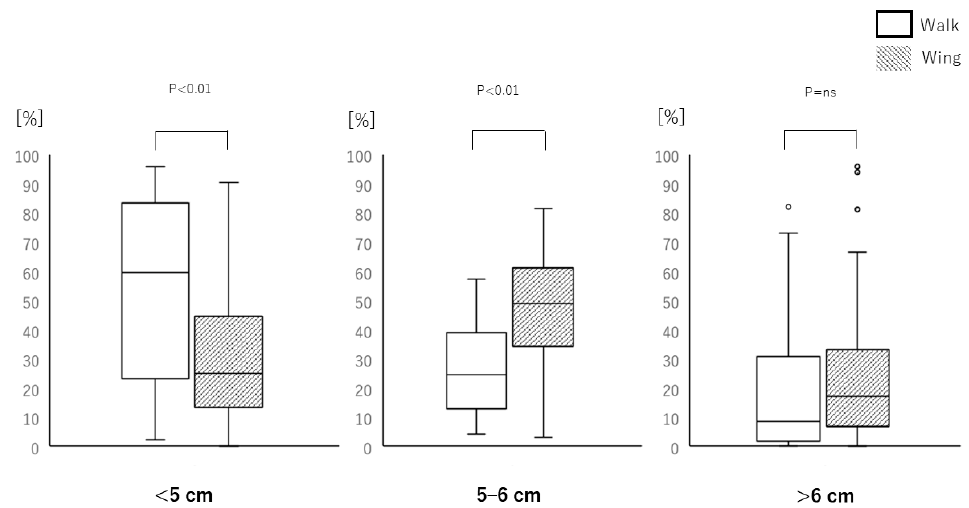
Figure 4. Data categorizing the percent of chest compression depths ( < 5 cm, 5–6 cm, or > 6 cm) achieved with the walk (white bar) and wing (grey bar) methods. The central boxes represent values from the lower to upper quartile (25th to 75th percentile) within each group. The middle horizontal lines represent the median (50th percentile), and the whiskers represent the 5th and 95th percentiles. The white bars represent the walk method and the grey bars represent the wing method. The p -values above each category show whether there was a significant di ff erence between the methods. The data were analyzed by Wilcoxon-signed rank